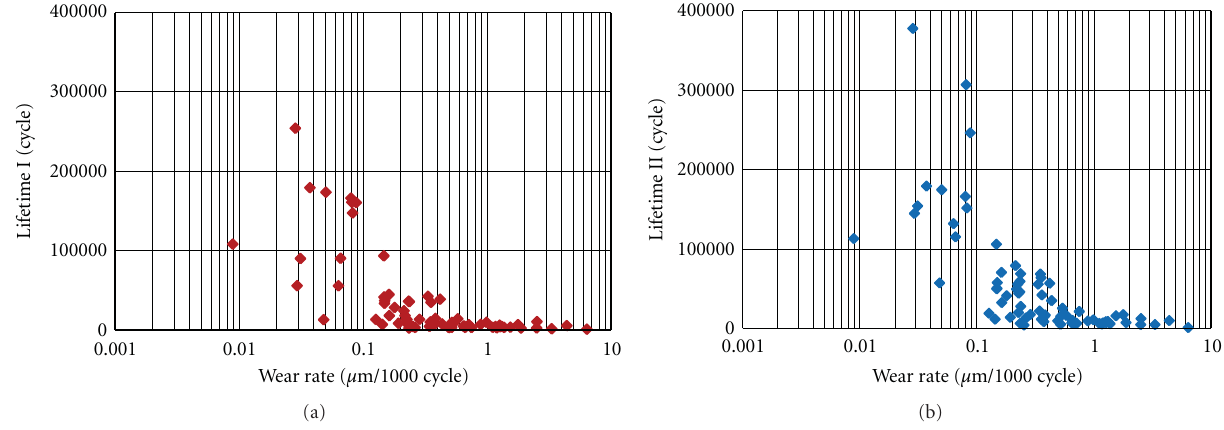
Figure 8: (a) Correlation between rate of wear of gold platings and lifetime I of electrical contacts. (b) Correlation between rate of wear of gold platings and lifetime II of electrical contacts.